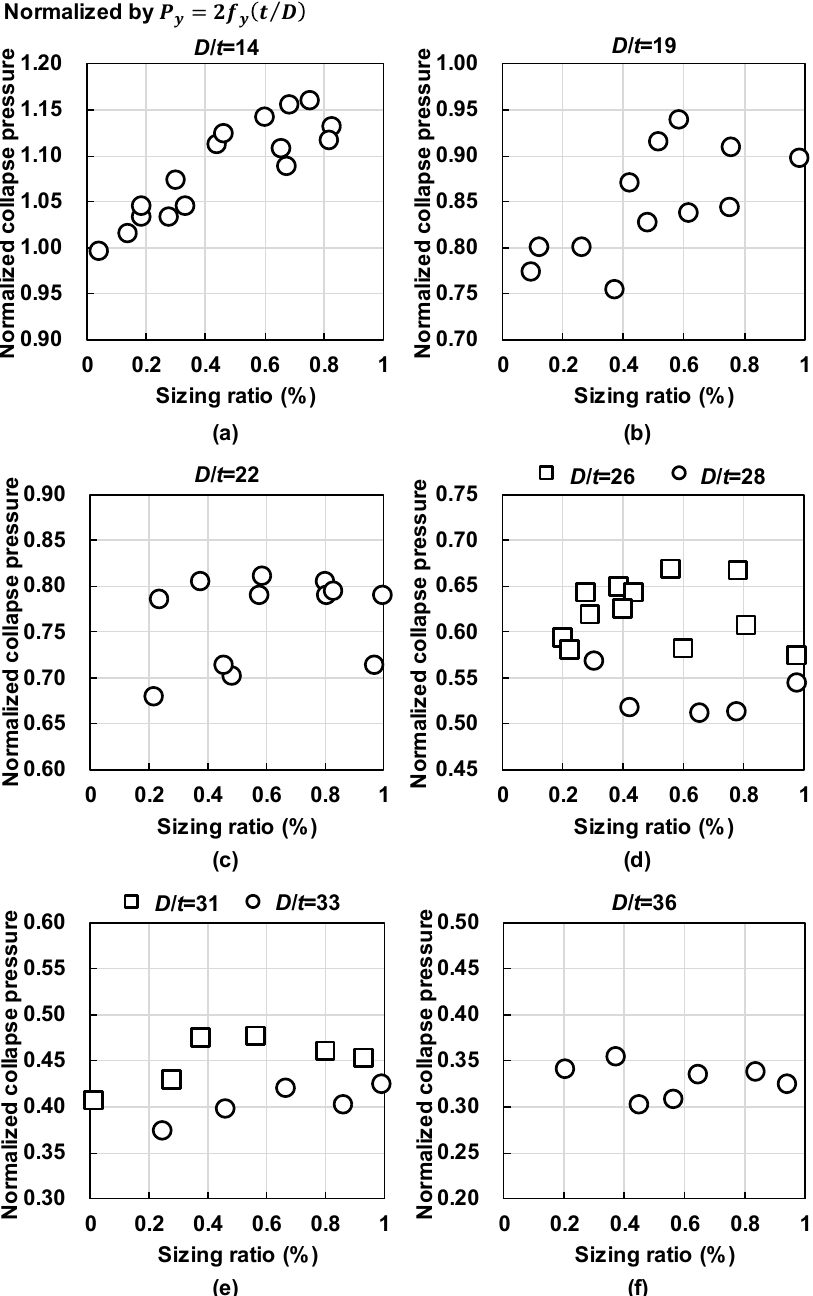
Figure 10. Effect of the sizing ratio on the collapse pressure: ( a ) D / t = 14; ( b ) D / t = 19; ( c ) D / t = 22; ( d ) D / t = 26 and 28; ( e ) D / t = 31 and 33; ( f ) D / t = 36.